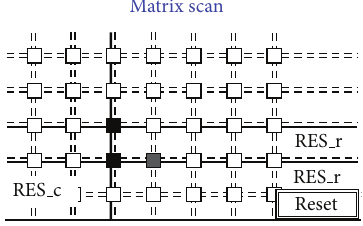
Figure 12: Second reset on the columns.